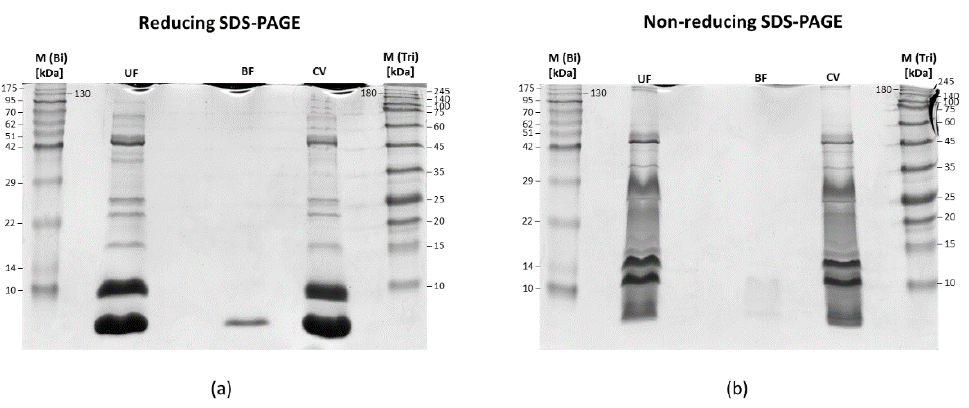
Figure 5. Representative gel images of the samples separated with SDS-PAGE under ( a ) reducing and ( b ) non-reducing conditions. Electrophoresis was performed on 17% stacking gels. UF (Upper fraction); BF (Bottom fraction); CV (Crude venom); M(Bi) (ROTI ® Mark BI-PINK protein mass marker); M(Tri) (ROTI ® Mark TRICOLOR mass marker).